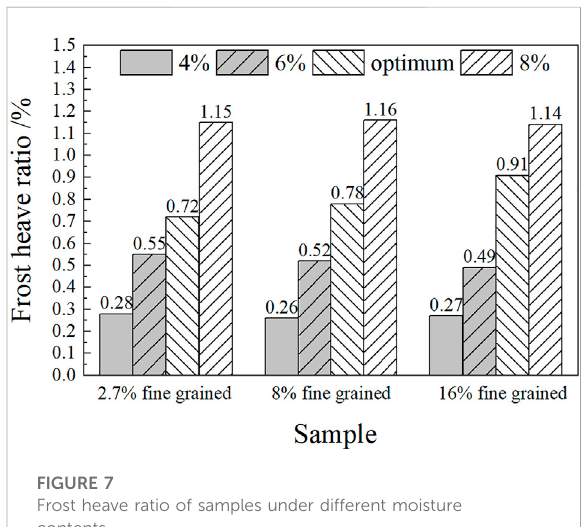
FIGURE 7 Frost heave ratio of samples under different